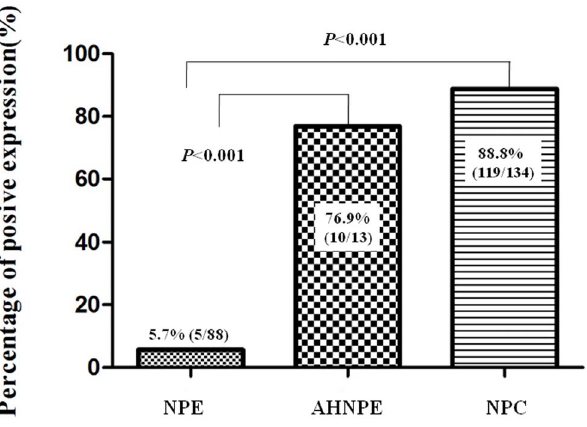
Figure 2. Expression of Flot-2 protein in NPC and atypical hyperplasia nasopharyngeal epithelia compared to the control nasopharyngeal mucosa epithelia. Results showed that there were significant differences between the groups which were statistically evaluated by chi-square test.